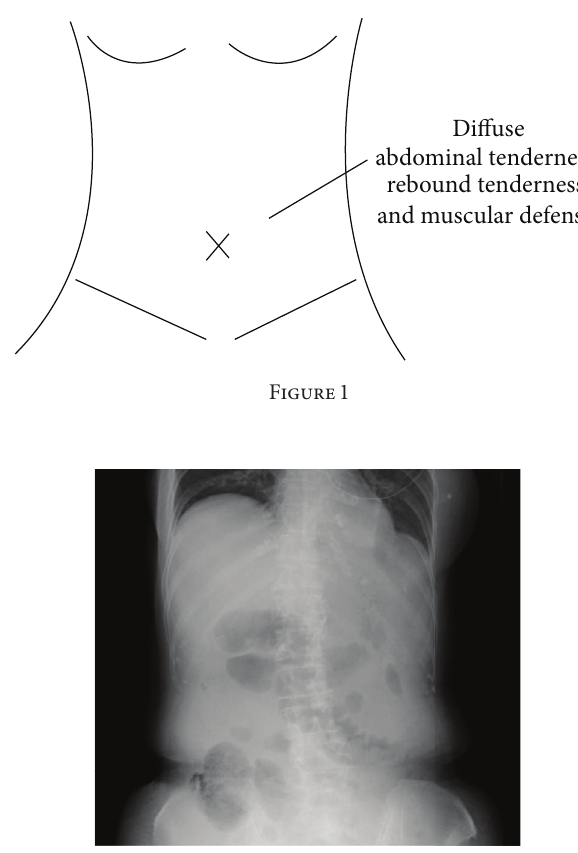
Figure 2: Plain abdominal X-ray film. No free intraperitoneal gas was observed.